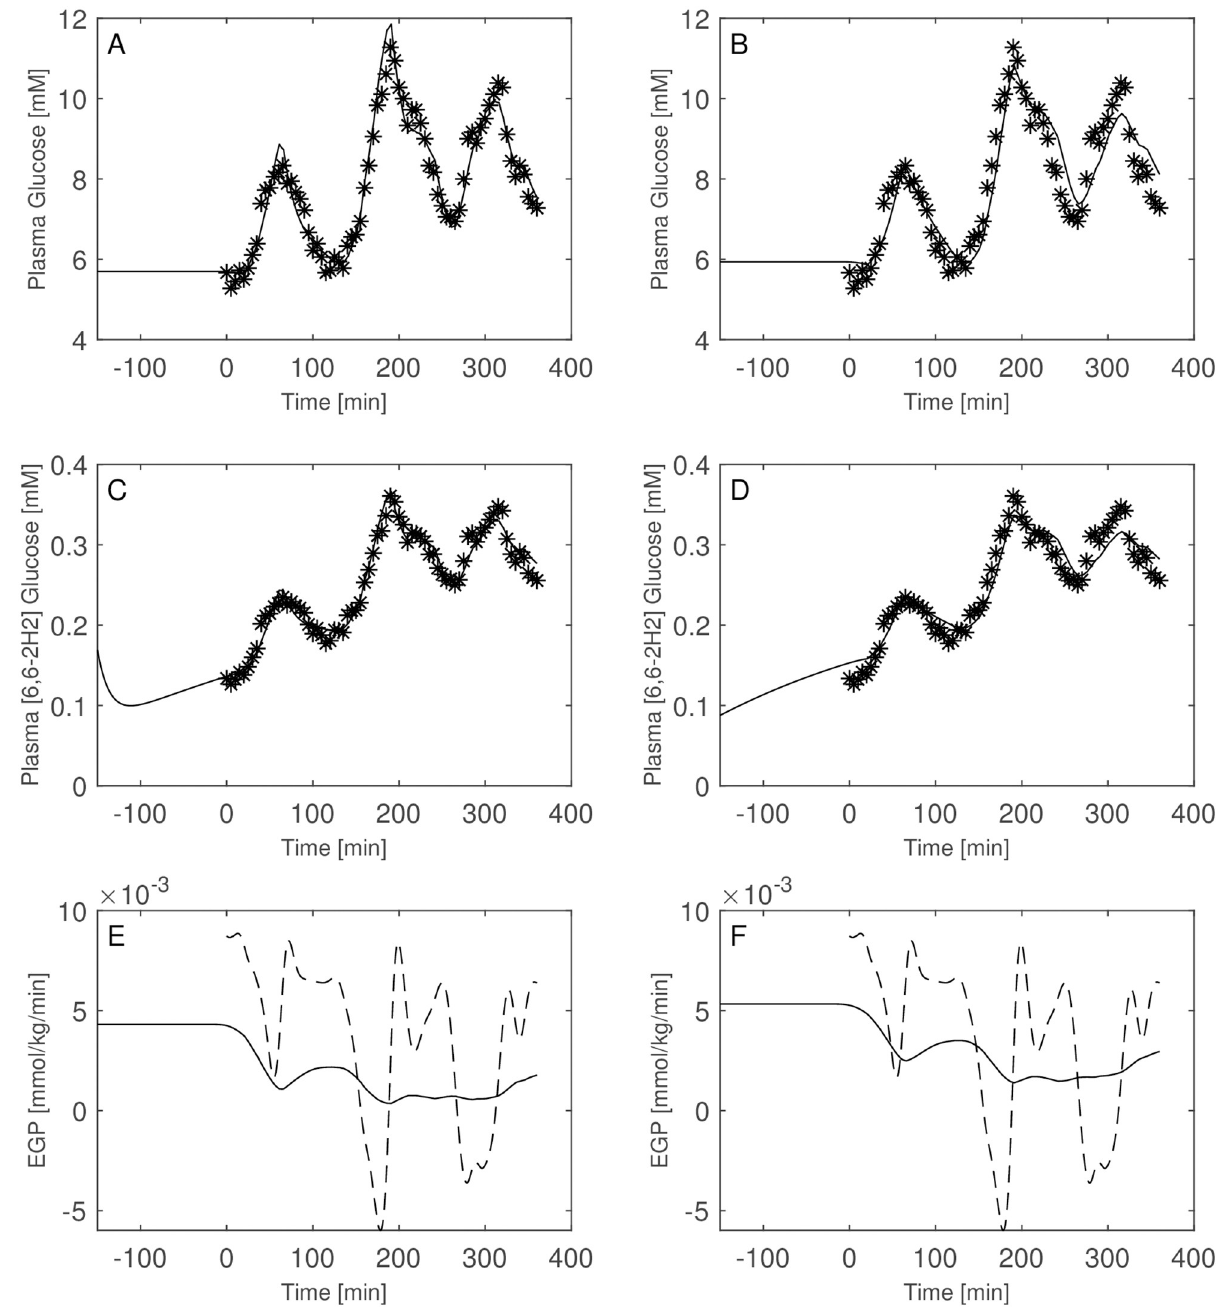
Fig 9. Model comparison for Subject 1. Observed (asterisks) and predicted (line) variables over time with glucose two-compartment model (Panels A, C, E) and one-compartments-glucose model (Panels B, D, F). Dashed line is the predicted EGP with the Steele model. All the observed points refer to data measured on day 2. Plasma glucose concentrations (panel A) are derived from the glucose intra-venous infusion to match plasma glucose observations from the OGTTs of day 1.